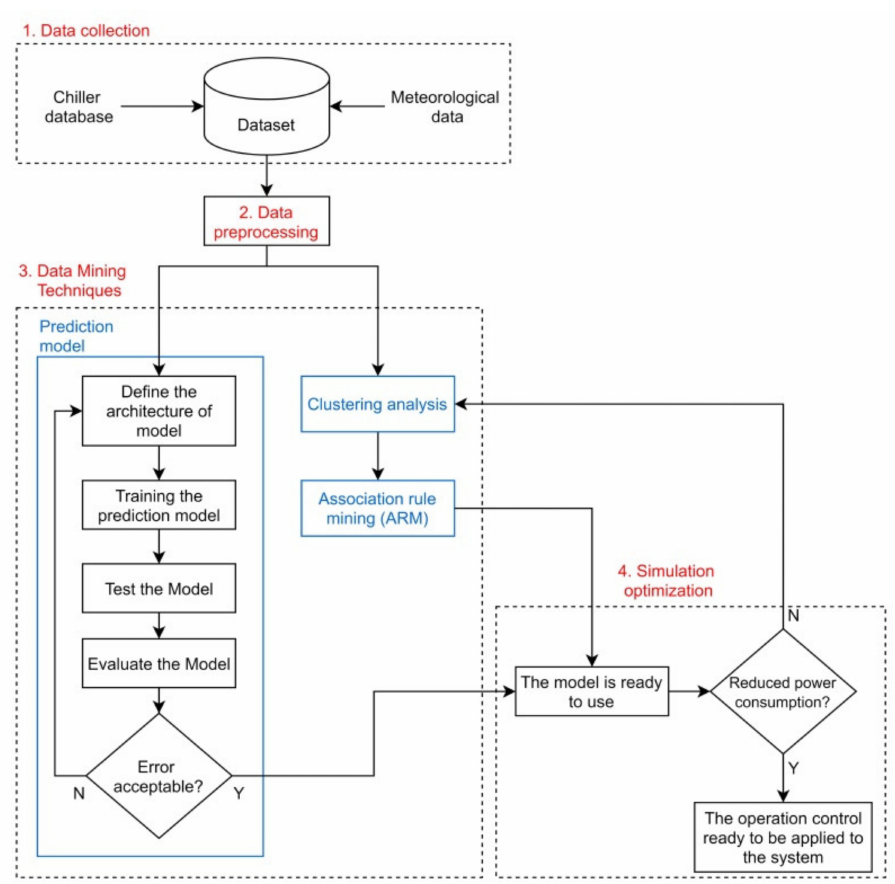
Figure 1. The proposed methodology